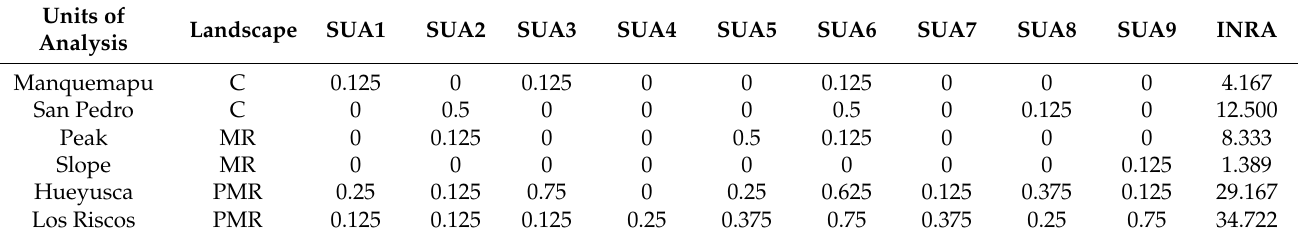
Table 2. Relative integrated anthropization index (INRA) with respective SUAs (subunits of analysis) by location in the coastal range of southern Chile. (C: coast, MR: mountain range, PMR: pre- mountain range).